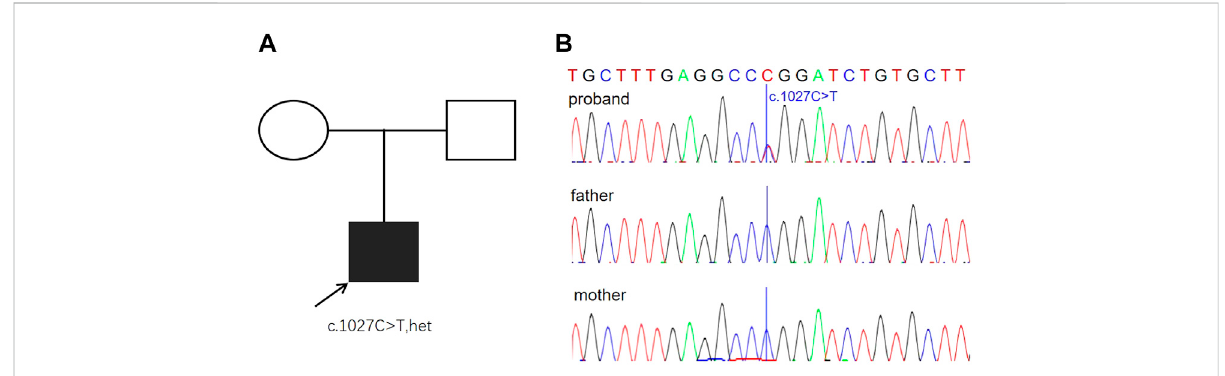
FIGURE 3 Genetic fi ndings from the family. (A) Pedigree of the family with segregation of the identi fi ed TP63 mutation. The square represents male, and circles represent female. The fi lled symbol indicates the affected individual. (B) Variation of c.1027C > T is a de novo missense mutation (R304W) identi fi ed in the proband. The parents were tested and did not carry the mutation. Blue lines indicate the point